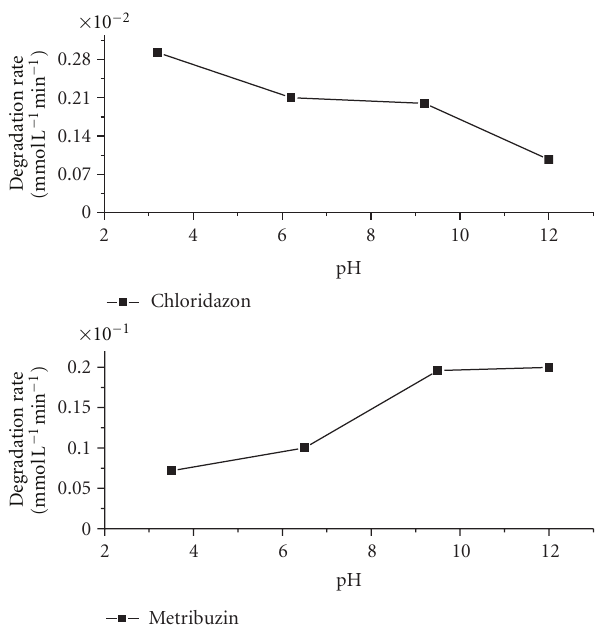
Figure 2: Influence of pH on the degradation rate of CHL and MET. Experimental conditions : CHL (0.18mM), MET (0.30mM), initial reaction pH of CHL (3.2, 6.2, 9.2, and 12), initial reaction pH of MET (3.5, 6.5, 9.5, and 12), V = 125 mL, photocatalyst: TiO 2 Degussa P25 (1gL − 1 ), irradiation time: 60 min (CHL), 28 min (MET).